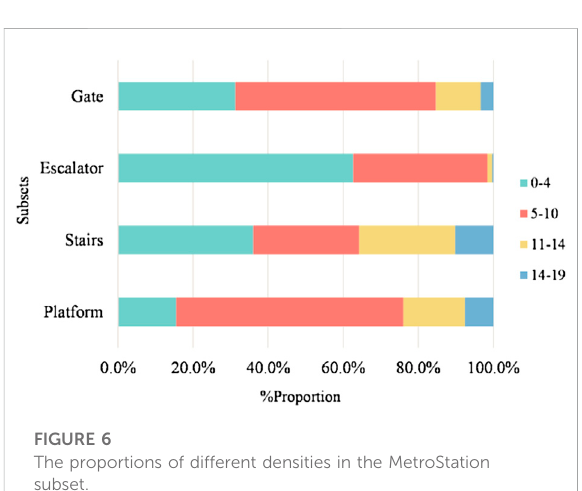
FIGURE 6 The proportions of different densities in the MetroStation